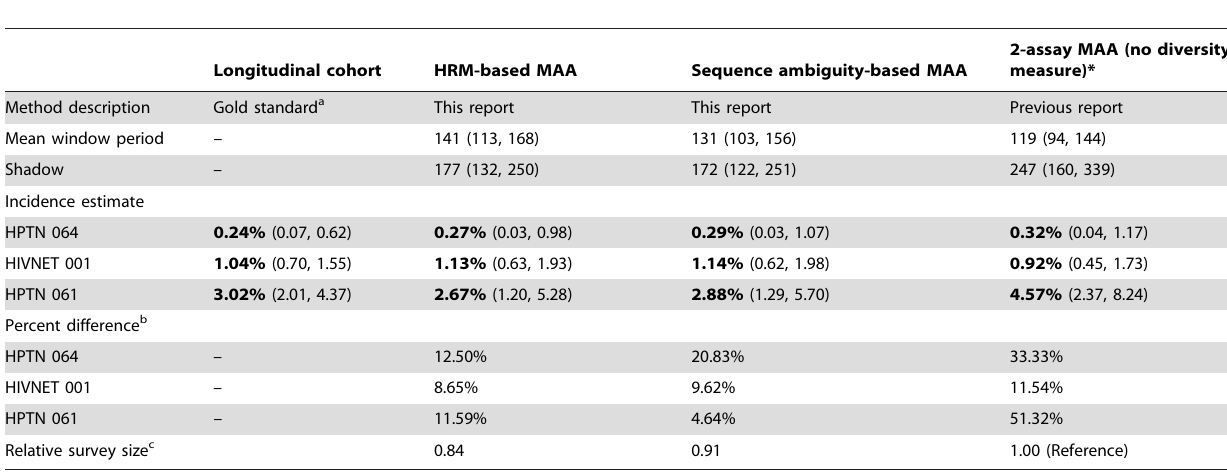
Table 2. Performance characteristics of MAAs and comparison of cross-sectional incidence estimates to longitudinal incidence estimates obtained for three clinical